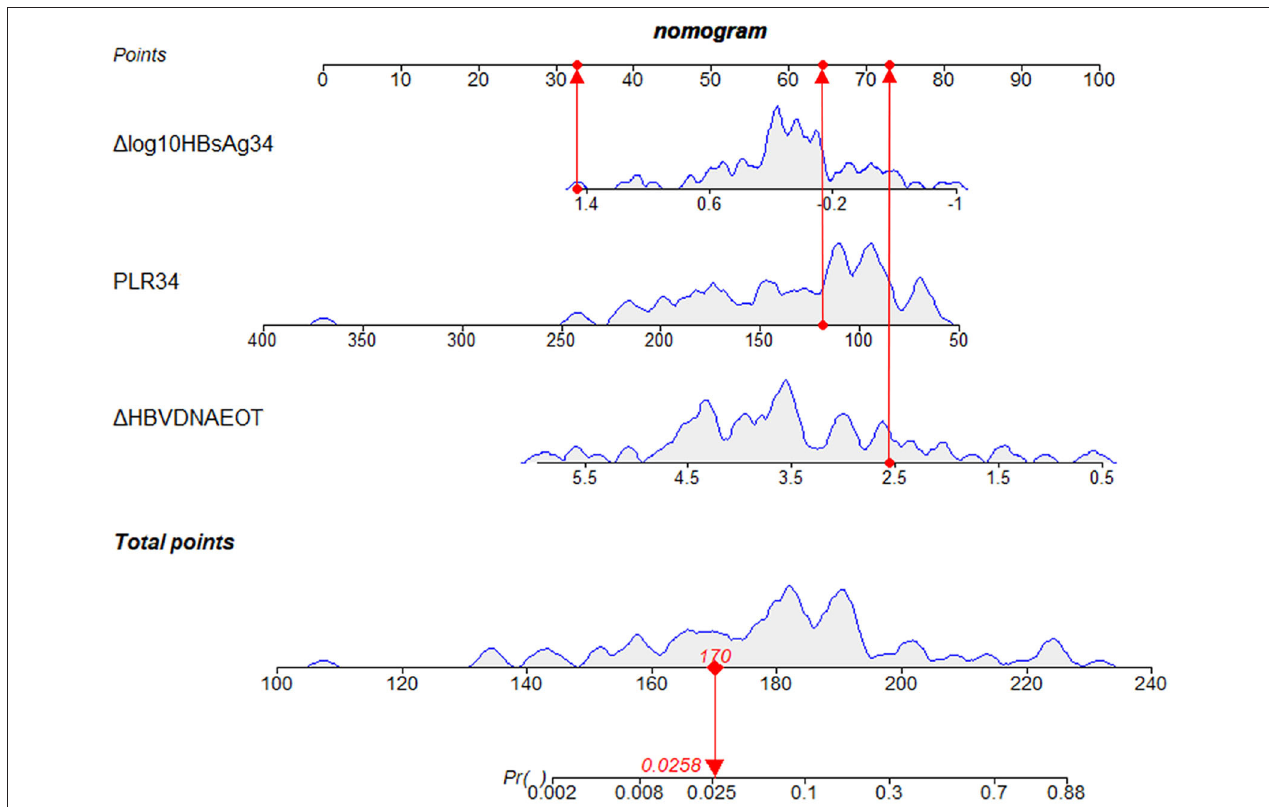
FIGURE 1 | A nomogram to predict the probability of non-rebound outcomes in patients. We took a given patient as an example to explain the meaning of the nomogram. Specifically, the values of 1 log 10 HBsAg34, PLR34, and 1 HBVDNAEOT about the given patient were 1.3 log 10 IU/ml, 118.64, and 2.56 log 10 IU/ml, respectively. The corresponding scores on the “Points” scale were 33, 64, and 73, respectively, which were presented as red dots. By summing the points of each independent parameter, the total points projected on the bottom scales were 170, which was presented as a red diamond on the line, indicating that the probability of a non-rebound outcome was 2.58%. PLR34, PLR at 34 ± 2 weeks of gestation; 1 log 10 HBsAg34, a decline of HBsAg from baseline to 34 ± 2 weeks of gestation; 1 HBVDNAEOT, a decline of HBVDNA from baseline to the end of treatment; Pr, probability of a non-rebound outcome.